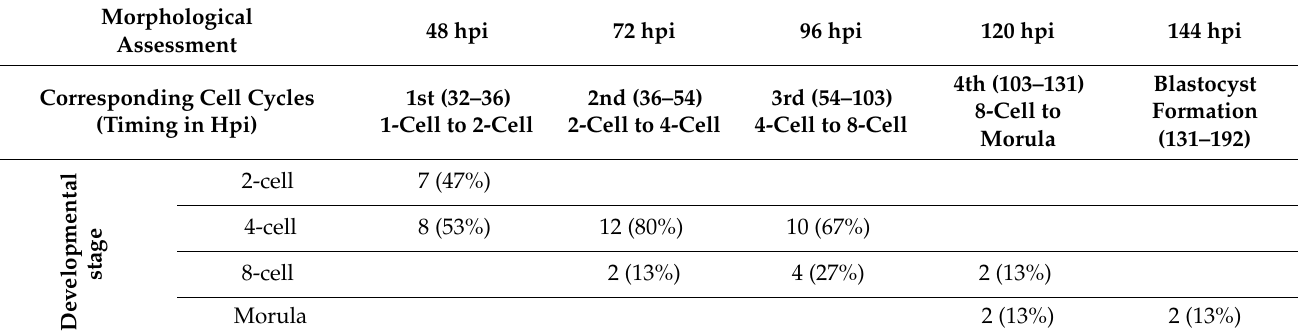
Table 2. Numbers and percentages (in brackets) of bovine embryos manipulated individually on the chips with the timing of the corresponding cell division cycles until blastocyst